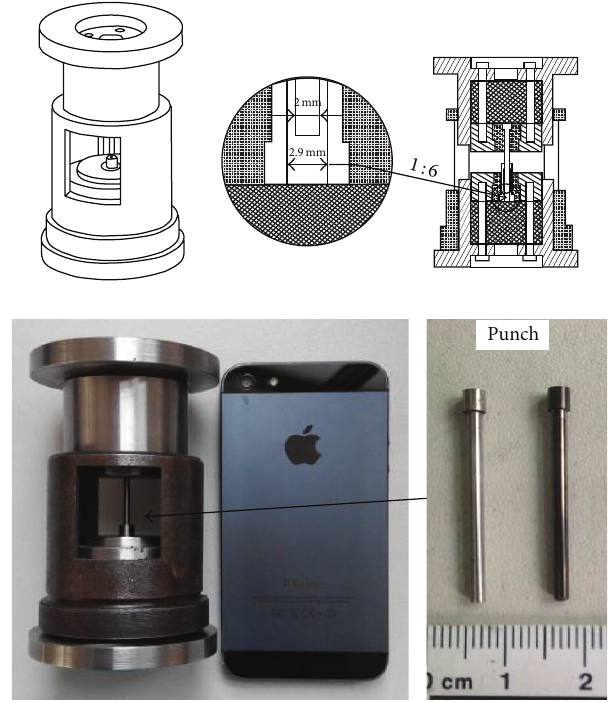
Figure 1: The microextrusion mold.